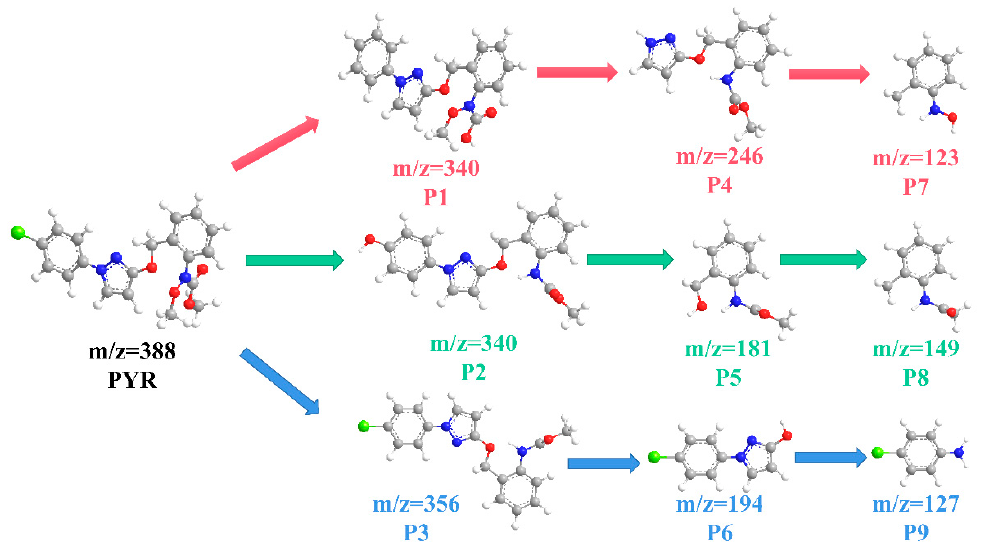
Figure 9. Possible degradation pathways of PYR in the NPG-LD system.